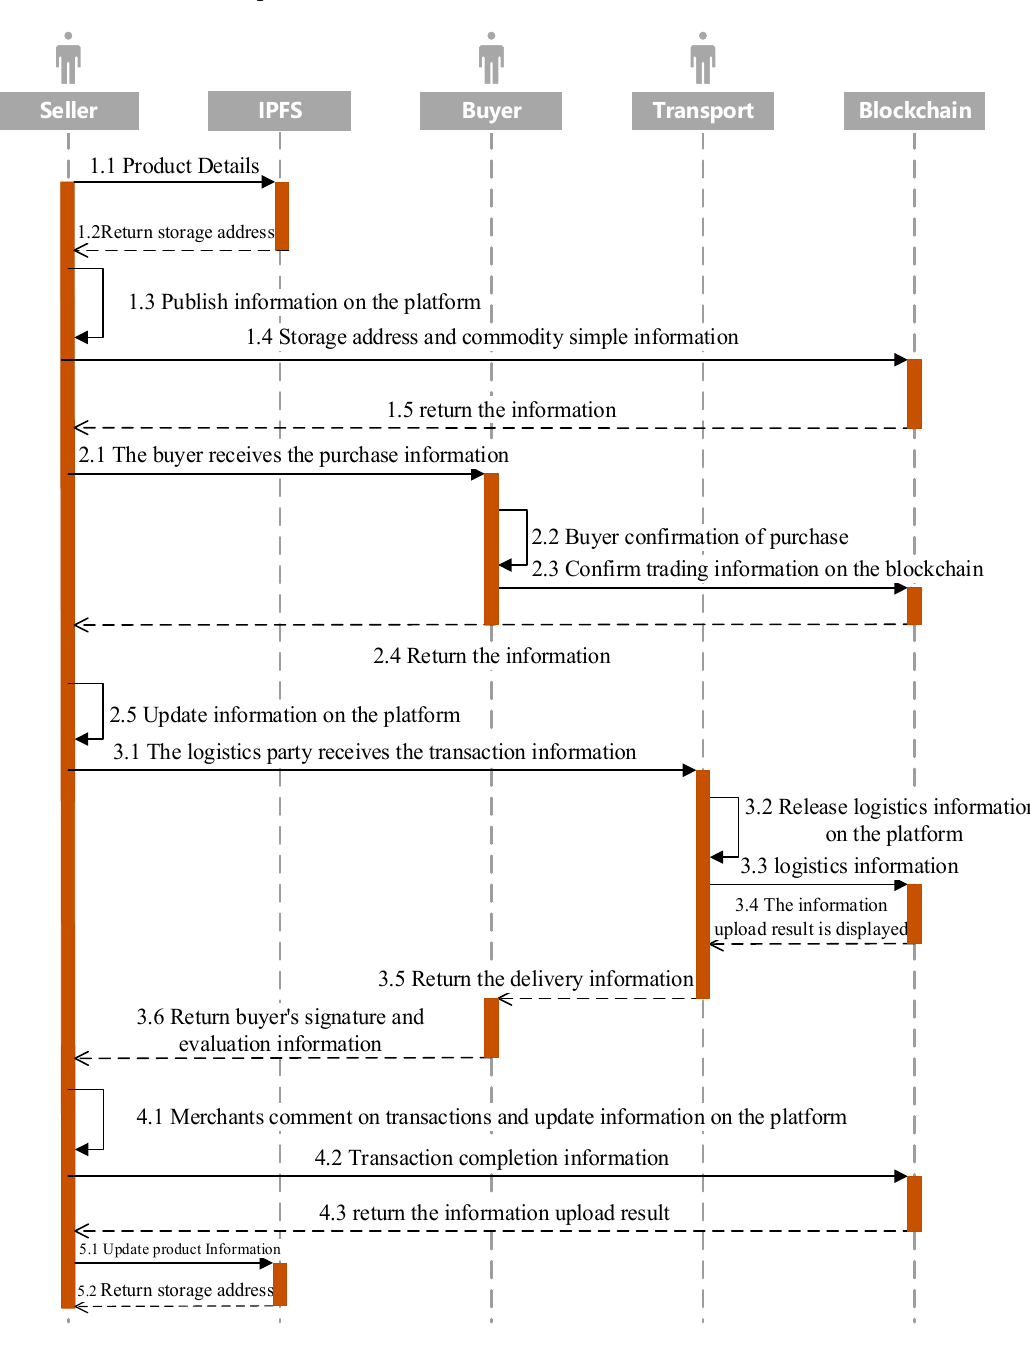
Figure 4. The UML Sequence diagram of e-commerce transaction system.